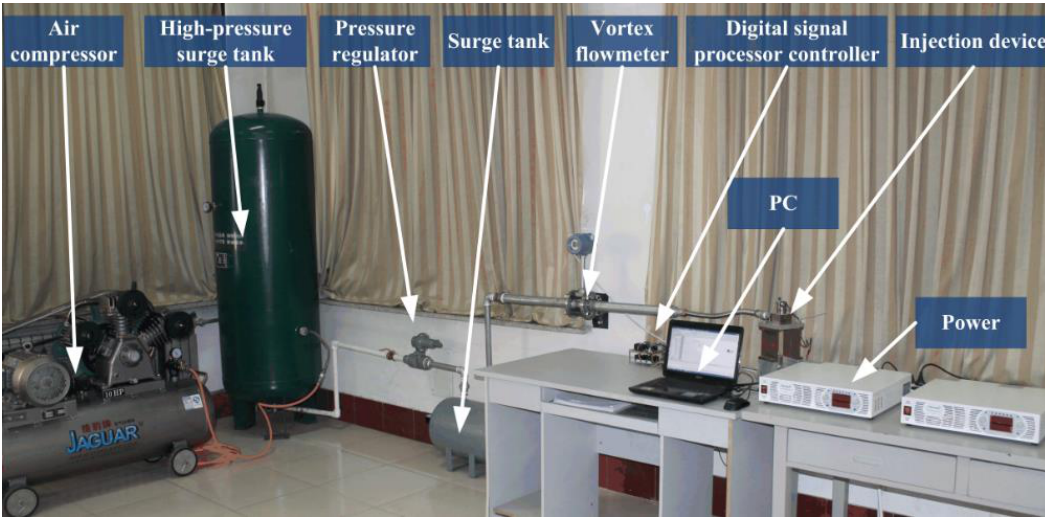
Figure 4. Results of grid independency check ( a ) Mass fraction distribution along the exit axis; ( b ) Mass fraction distribution in the radial direction.